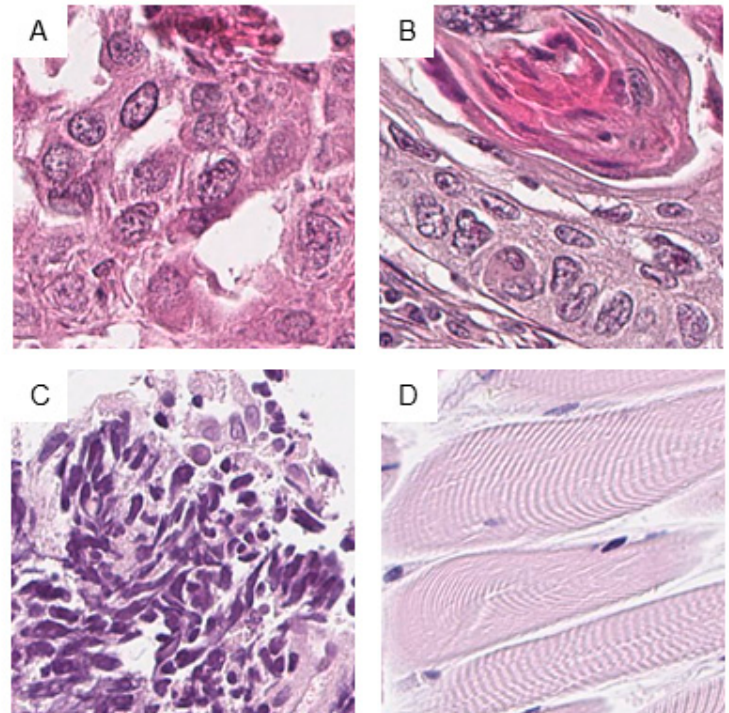
Figure 2. Examples of image patches from annotated areas. One representative image patch from adenocarcinoma (ADC) ( A ), squamous cell carcinoma (SqCC) ( B ), small-cell lung cancer (SCLC) ( C ), and skeletal muscle ( D ) is shown. Magnification or scale bars: each image 100 × 100 µm (395 × 395 px).